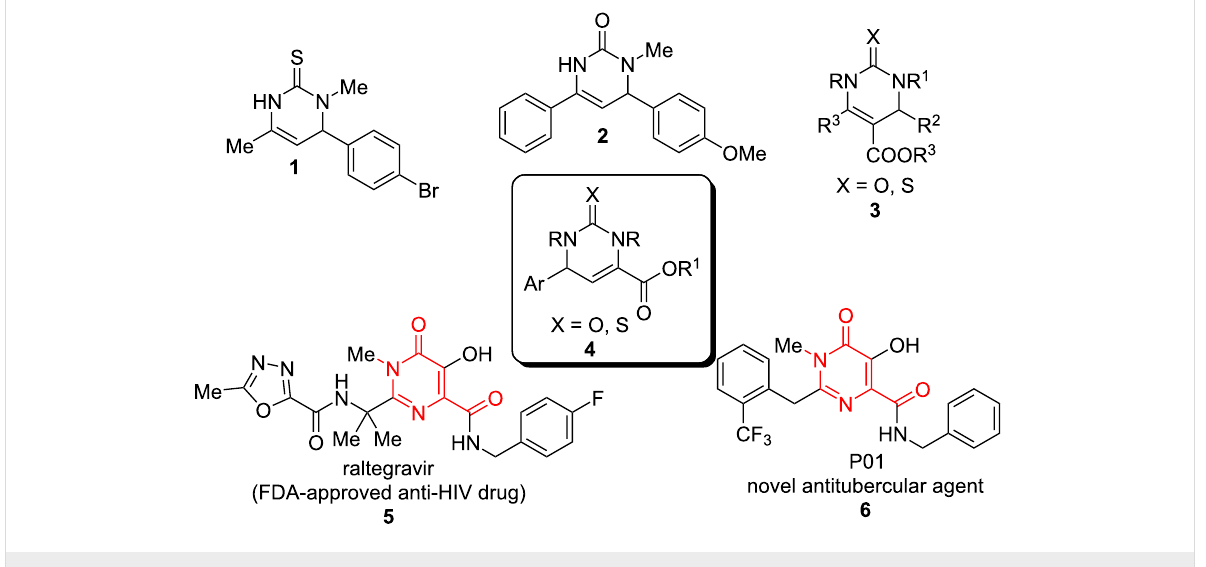
Figure 1: Biologically active functionalized DHPMs.